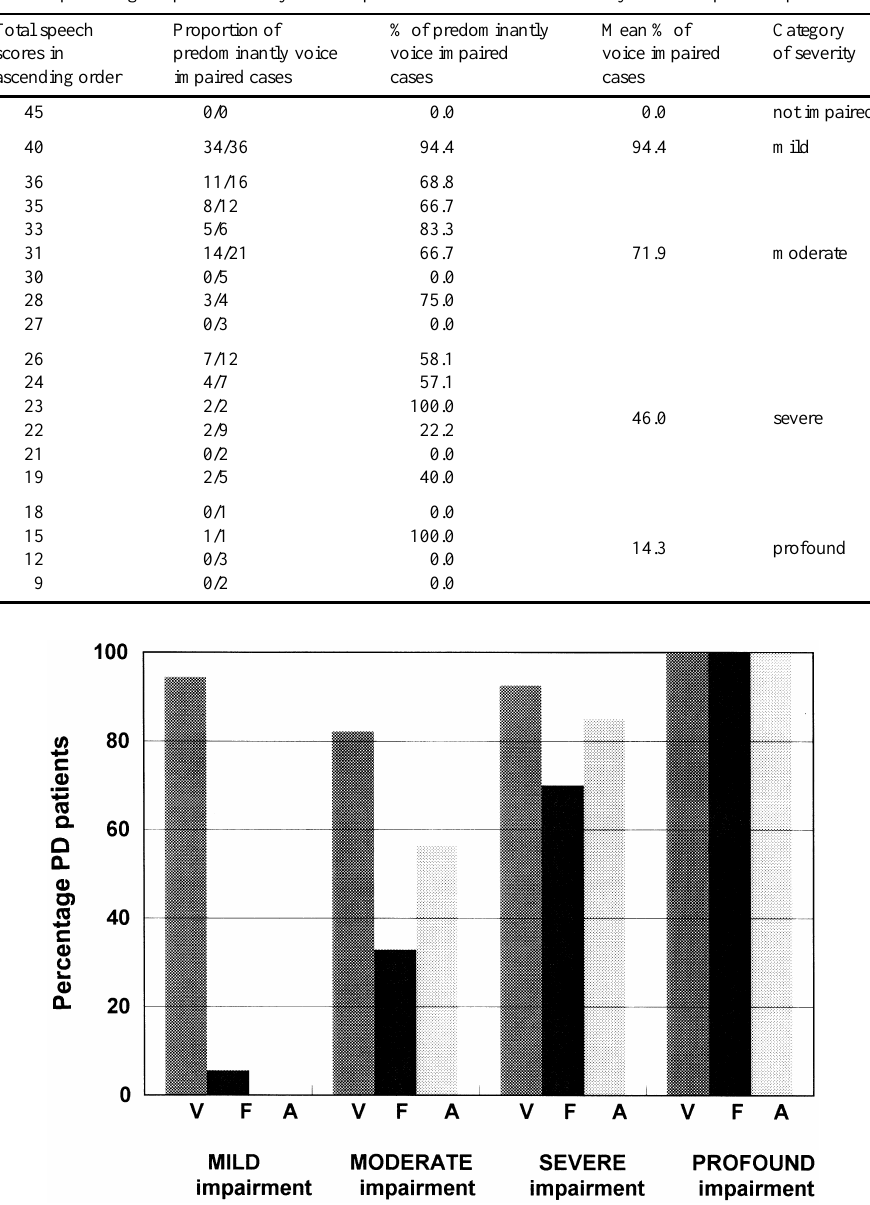
Table 1 Mean percentage of predominantly voice impaired cases for different severity levels of speech impairment